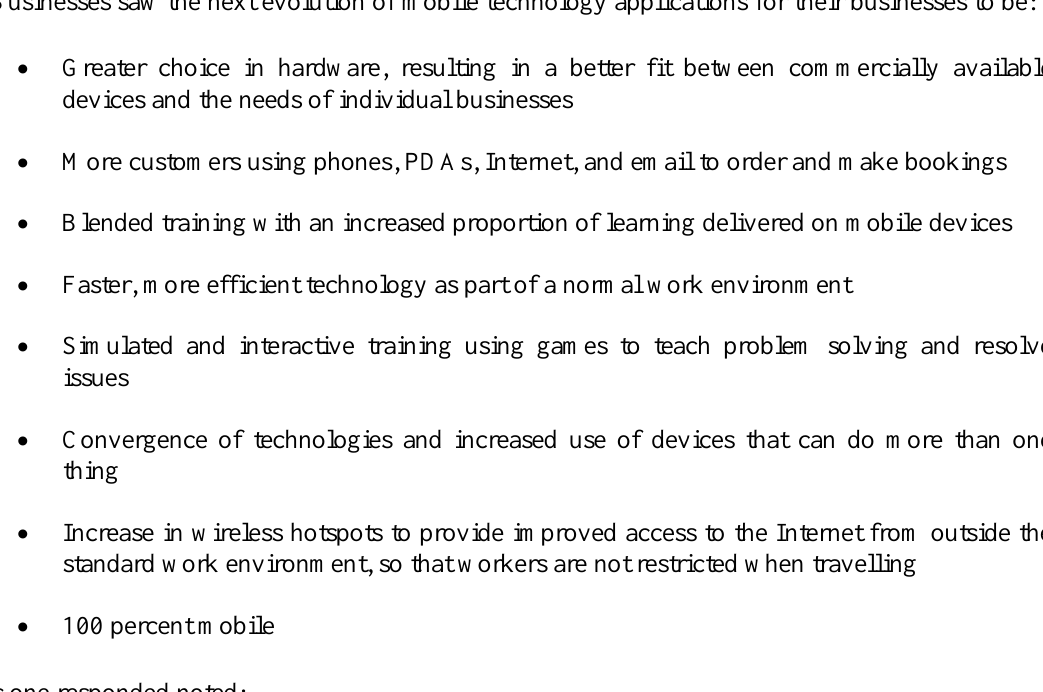
Businesses saw the next evolution of mobile technology applications for their businesses to